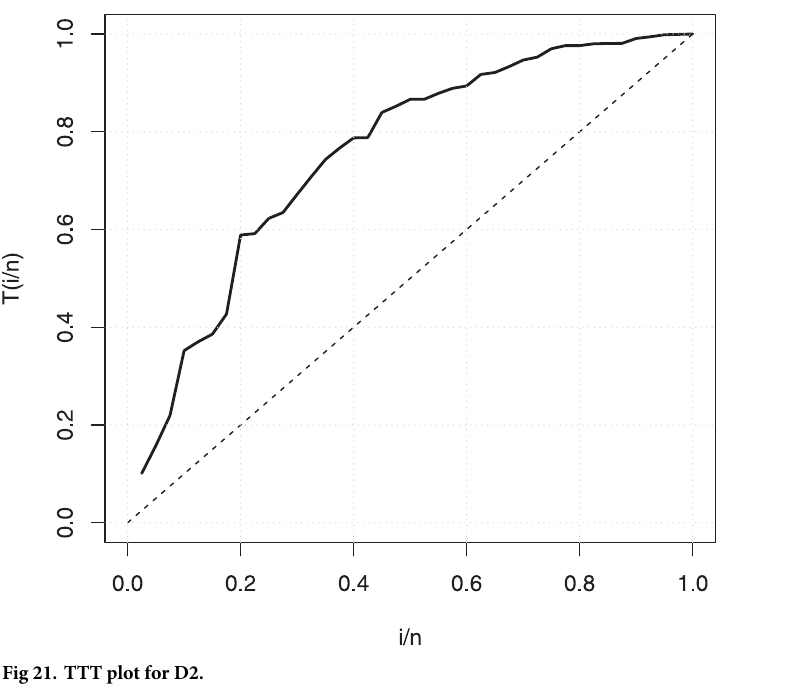
Fig 21. TTT plot for D2.